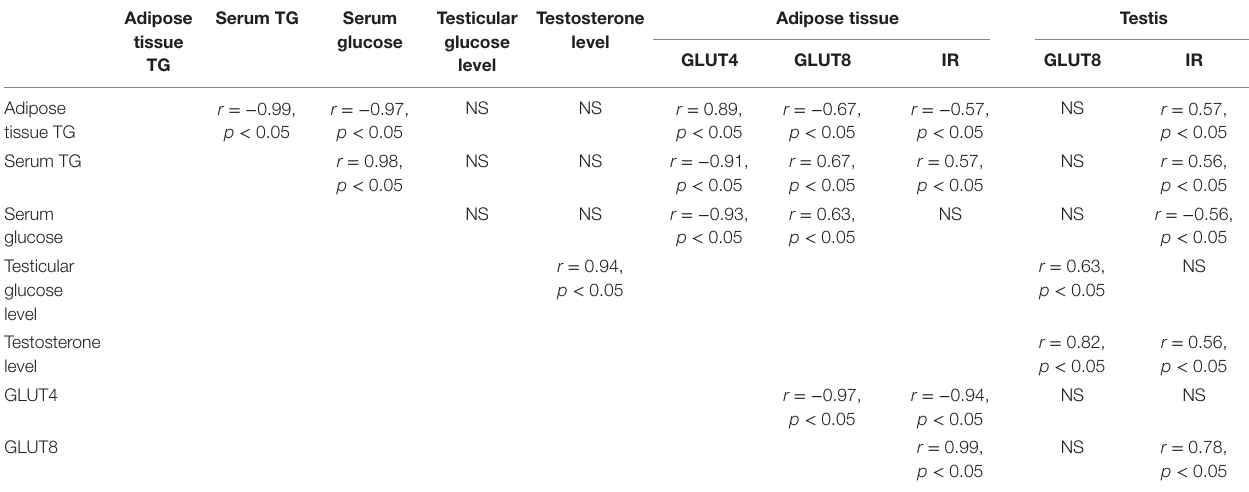
TaBle 4 | correlation studies of gnih treatment between the different parameters in adipose tissue and testis ( in vivo ). adipose